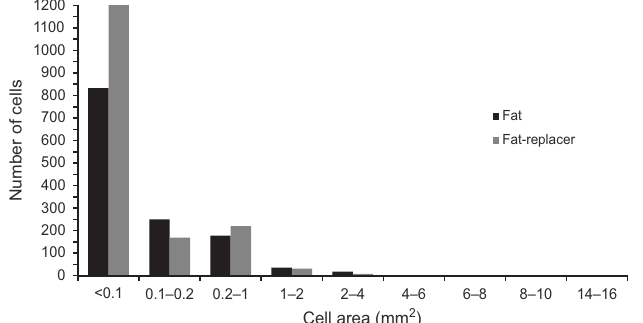
FIGURE 2 - Histogram: Number of cells by cell area of loaves produced with fat and with fat